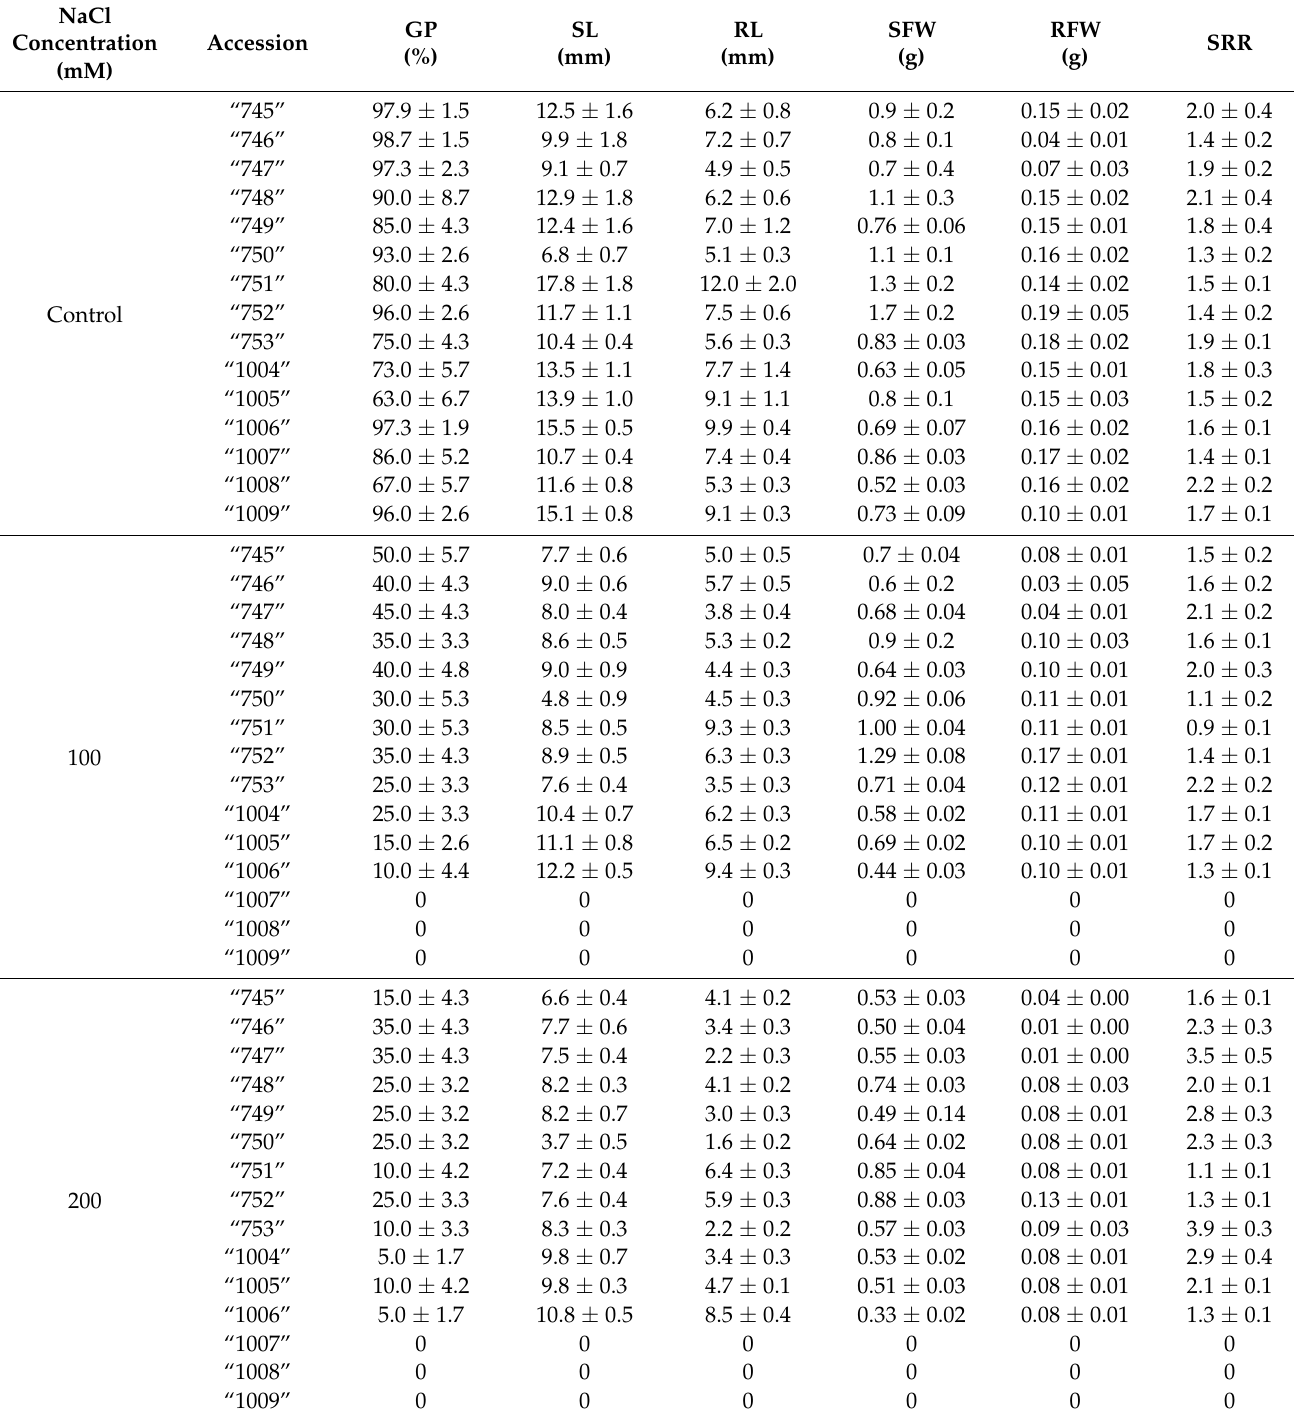
Table 4. Response of squash germplasm accessions to varying salt stress levels (0, 100, 200 and